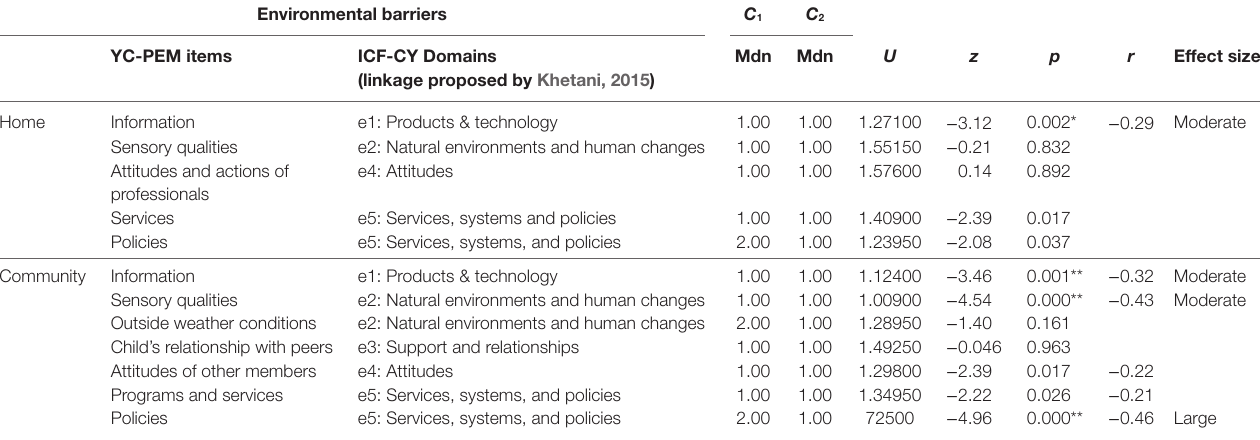
TaBle 4 | Differences between children with SEN ( C 1 ) and children without SEN ( C 2 ) in each environmental factor linked to the ICF-CY domains by Khetany (2015) at home and in the